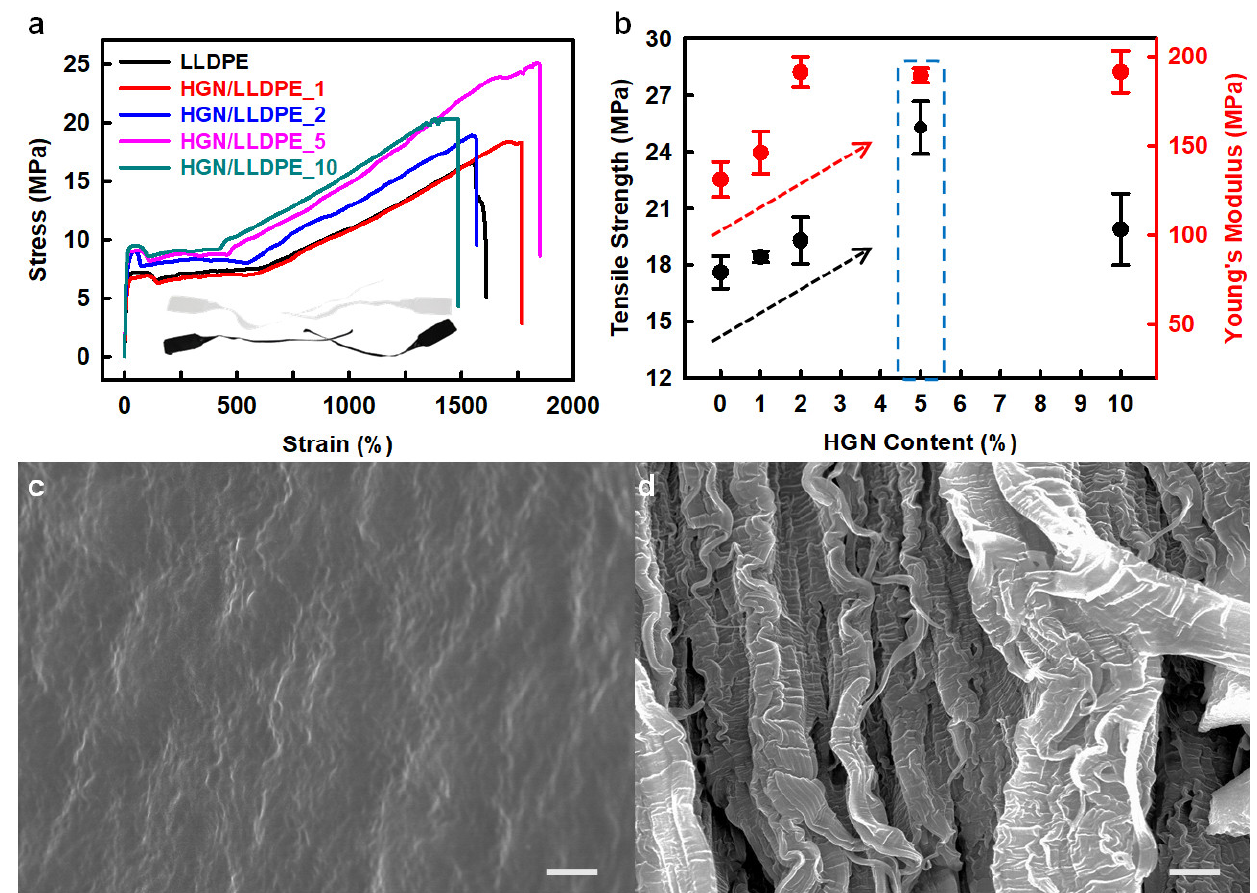
Figure 5. ( a ) stress–strain (S–S) curves of the pure LLDPE and HGN/LLDPE nanocomposites. ( b ) Tensile strengths and Young’s modules of the pure LLDPE and HGN/LLDPE nanocomposites according to HGN content. SEM images of the fractured surface: ( c ) pure LLDPE, and ( d ) HGN/LLDPE_5. Scale bars are 10 μm. Reprinted with permission from Ref. [40]. Copyright 2020 Elsevier.